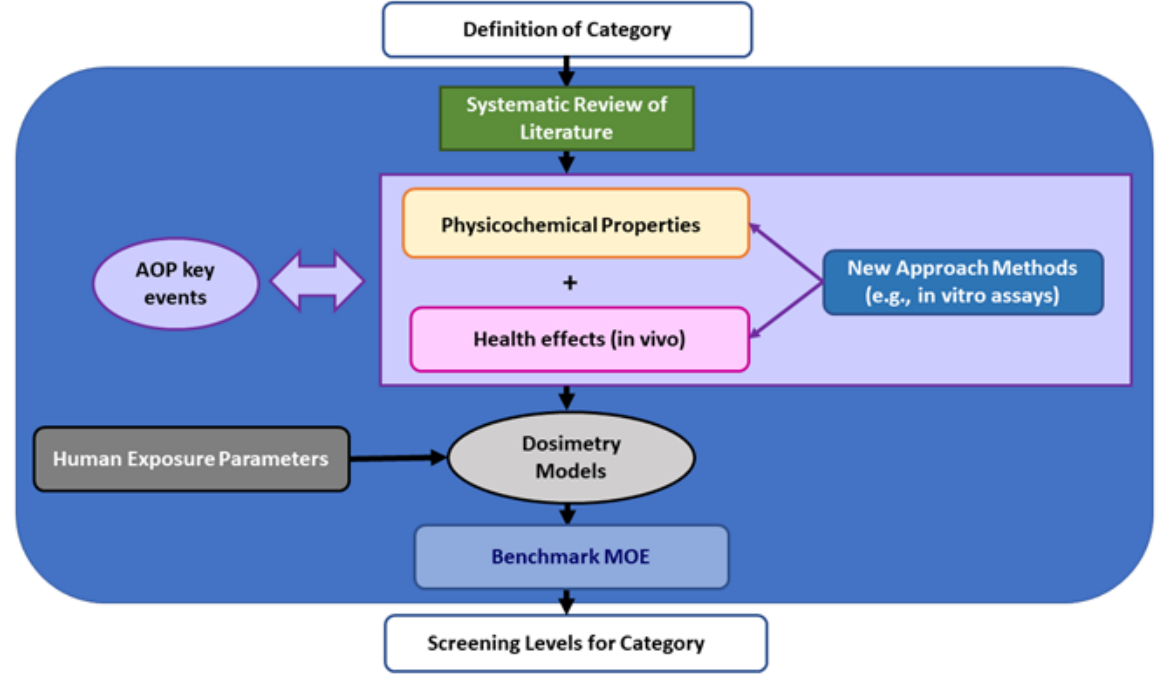
Figure 10. General schematic of an integrated approach to testing and assessment (IATA) for con- structing chemical categories used to screen new chemical substances under TSCA. AOP, adverse outcome pathway; MOE, margin of exposure (Part of NAM-06 presentation, Supplemental File).